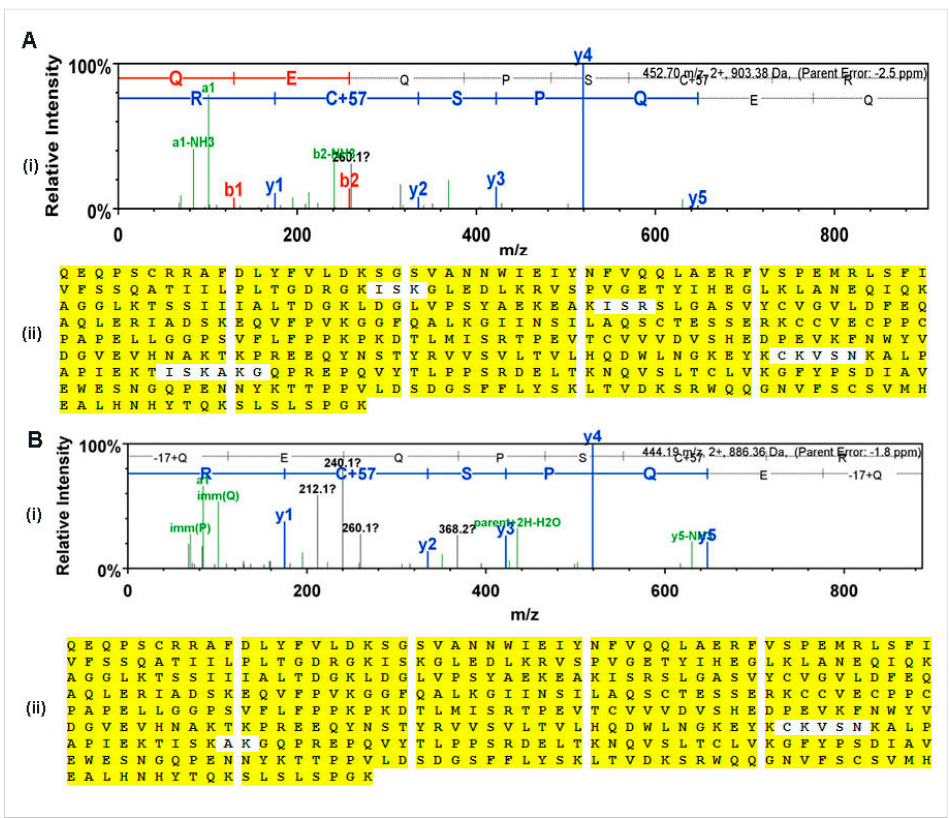
Figure 5. Mass spectrometry analysis: ( A ) rCMG2-Fc-Apo purified from whole leaf extract ( B ) rCMG2-Fc-Apo purified from apoplast wash fluid. ( i ): Unique peptide QEQPSCR was identified from the N -terminal region of mature protein purified from whole leaf extract and apoplast wash fluid. The b ions shown on the spectrum extend from the N -terminus and y ions shown on the spectrum extend from the C -terminus of the tryptic peptides. The colors indicate the loss of ammonia or water from either b or y ions (green), doubly charged b ions (red) and doubly charged y ions (blue). ( ii ): Peptide coverage of rCMG2-Fc-Apo protein. The white color background indicates the uncovered region and yellow color background indicates the peptide